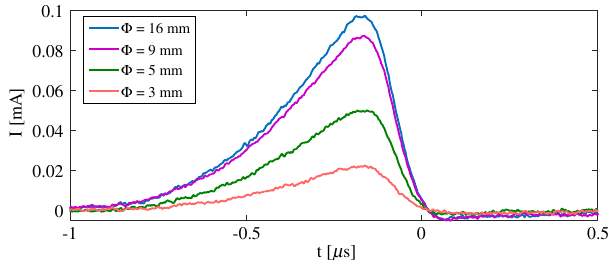
FIG. 18. ICT signals at the end of SITF using several aperture diameters, Φ , of the